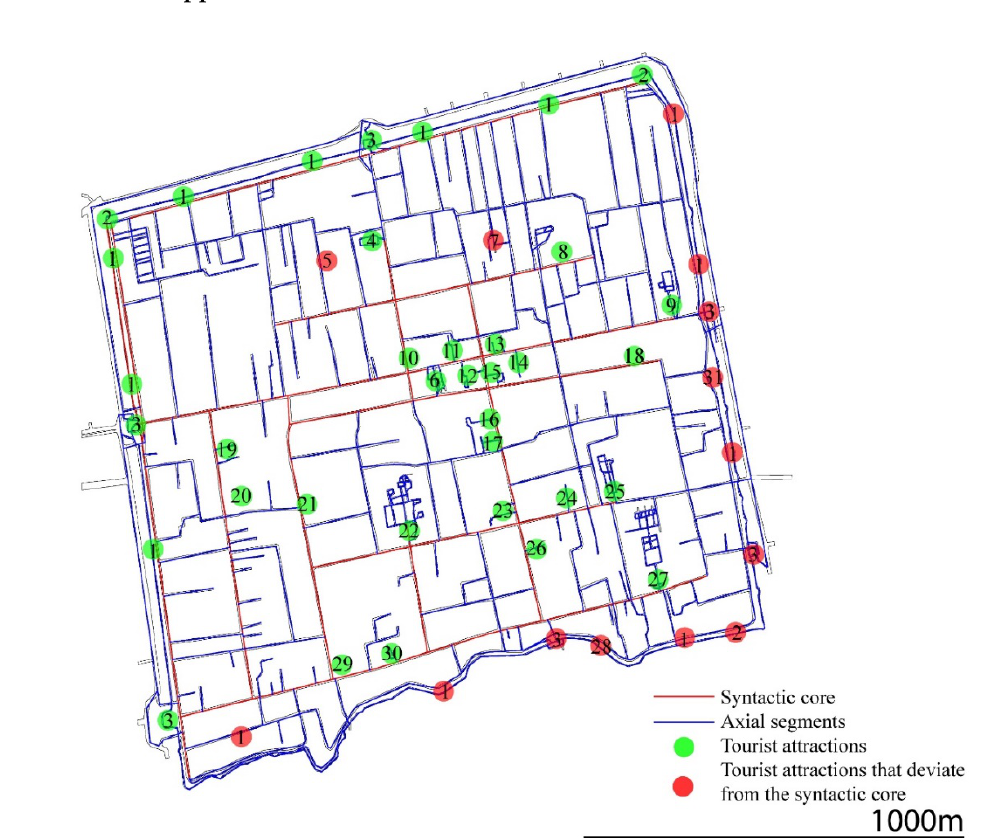
Figure A1. The POI tourist attraction distribution in Pingyao. The red colour indicates that tourist attractions deviate from the syntactic core of the